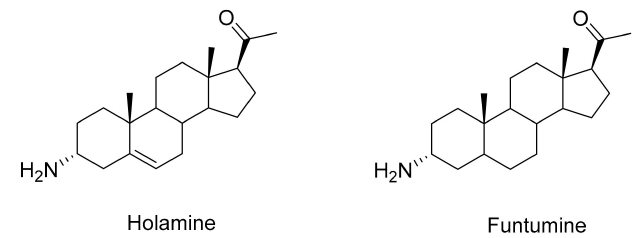
Figure 1. Structures of holamine and funtumine steroidal alkaloids isolated from Holarrena floribunda